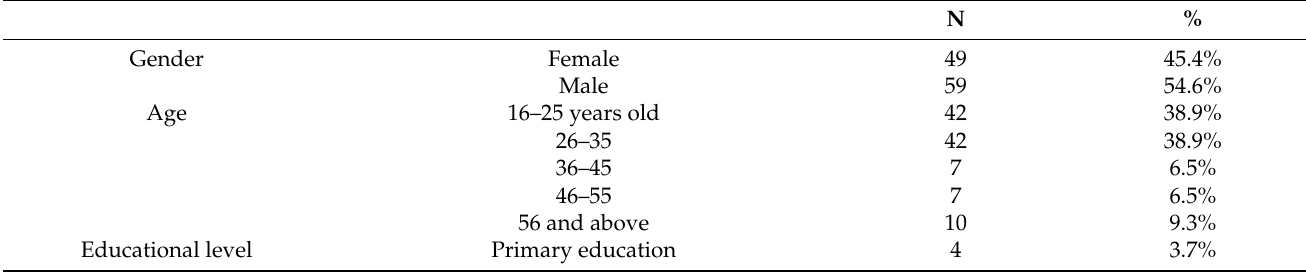
Table A12. Sample demographical